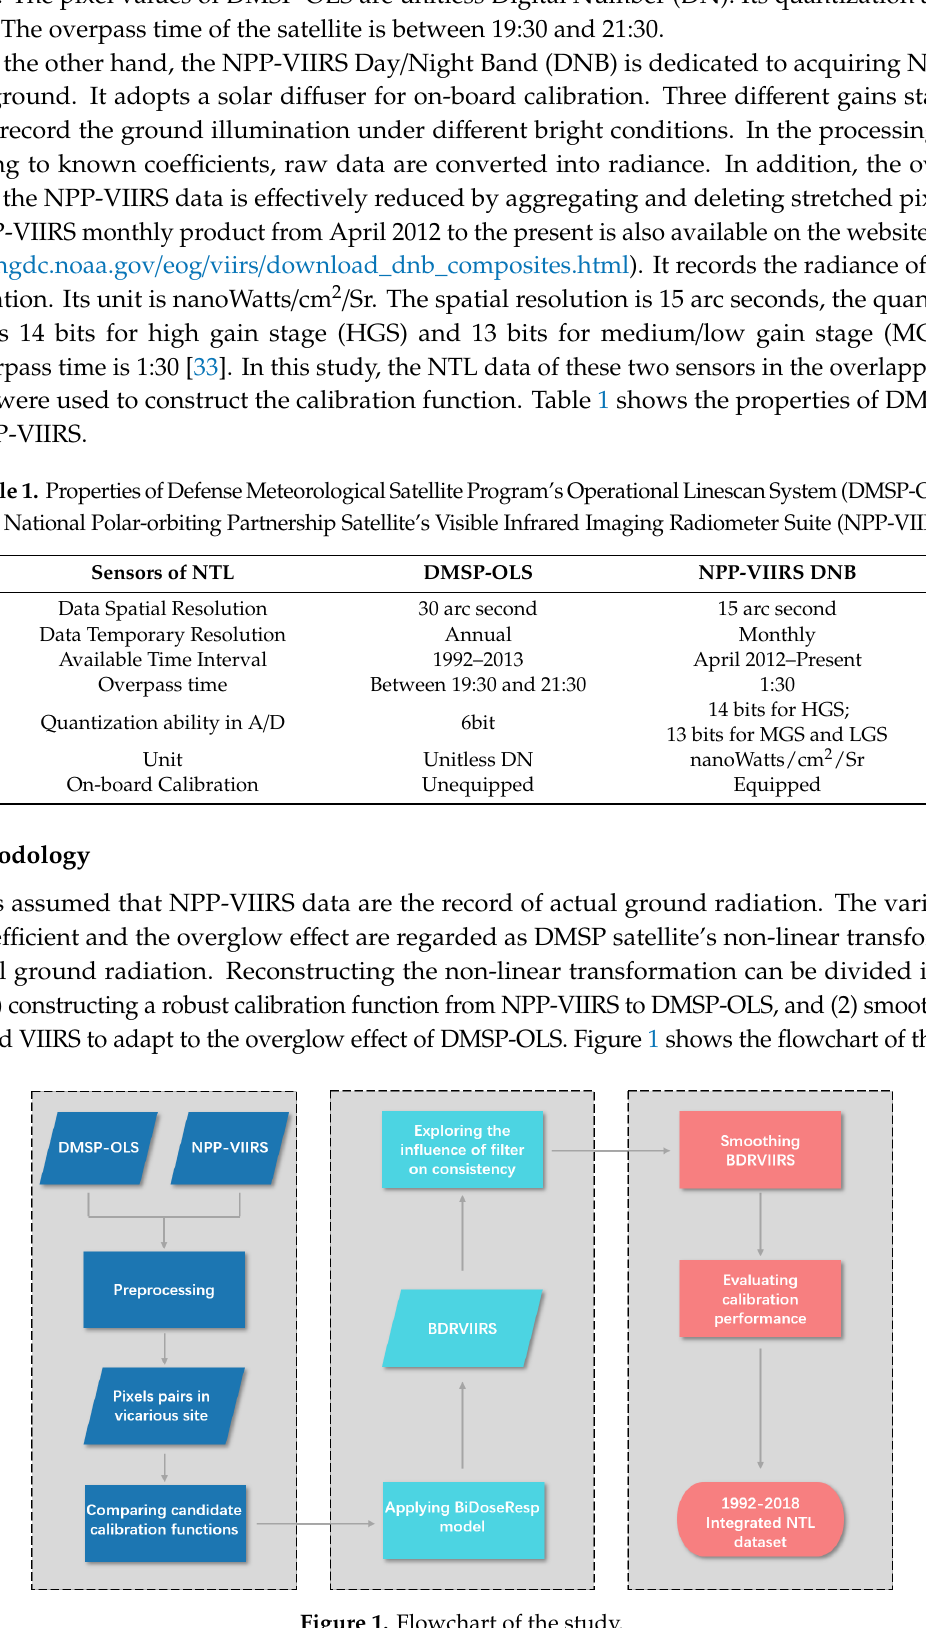
Figure 1. Flowchart of the study.